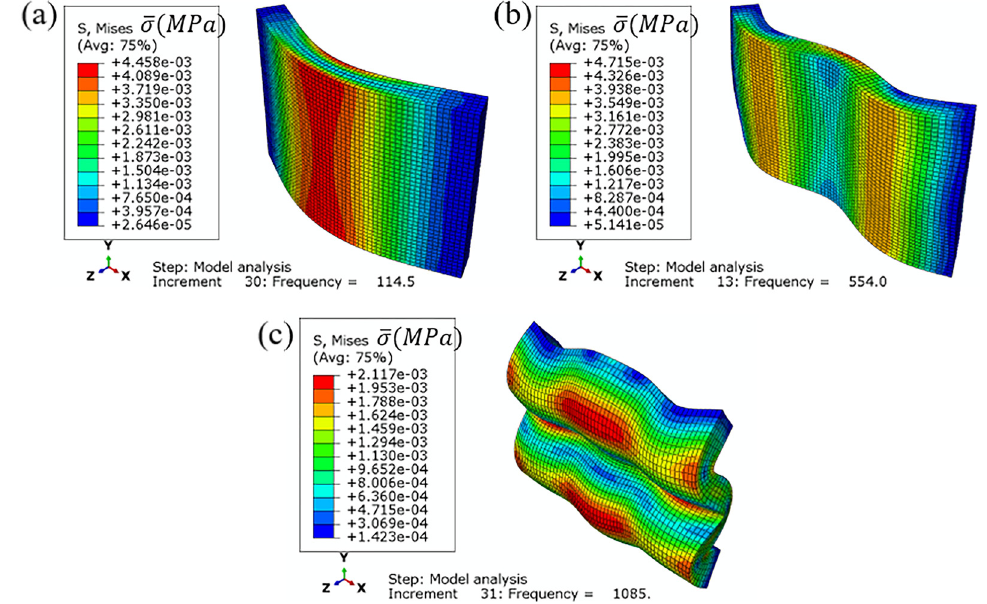
Figure 10. Mises stress cloud of finite element model, ( a ) 114.5 Hz, ( b ) 554.0 Hz, ( c ) 1085.0 Hz.